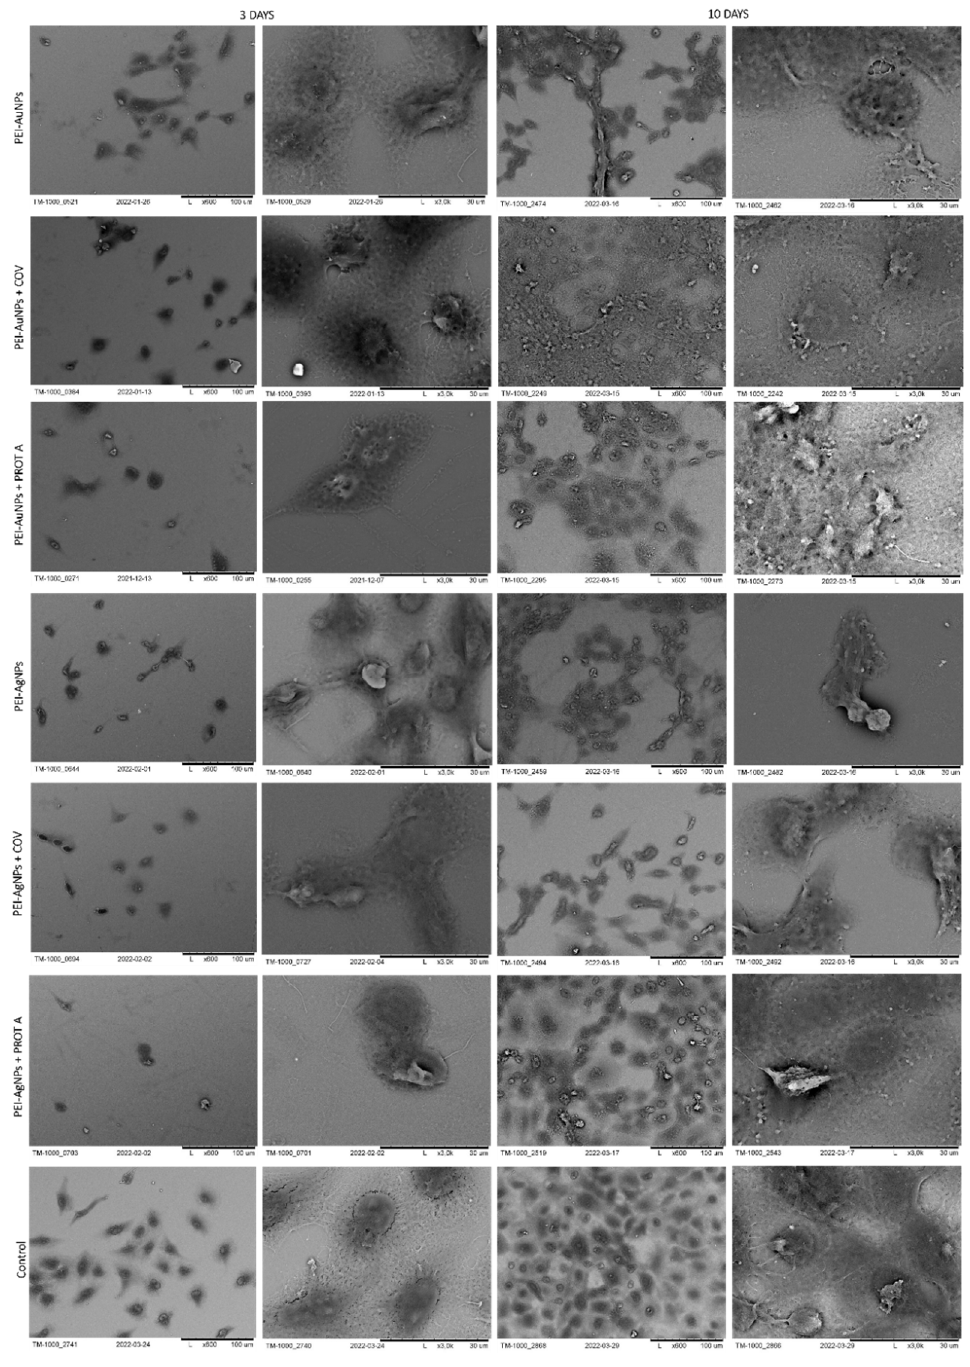
Figure 6. SEM visualization of A549 cells adsorbed within designed membranes after a 3- or 10-day culture. As a control, served cells cultured on glass slides without the membranes. Key to the symbols: PEI-AuNPs: the membrane build of the polyethylenimine with AuNPs incorporated; PEI-AuNPs + COV: the membrane build of the polyethylenimine with incorporated AuNPs with adsorbed COV; PEI-AuNPs + PROT A: the membrane build of the polyethylenimine with AuNPs incorporated with adsorbed Protein A; PEI-AgNPs: the membrane build of the polyethylenimine with AgNPs incorporated; PEI-AgNPs + COV: the membrane build of the polyethylenimine with AgNPs incorporated with adsorbed COV; PEI-AuNPs + PROT A: the membrane build of the polyethylenimine with AgNPs incorporated with adsorbed Protein A.